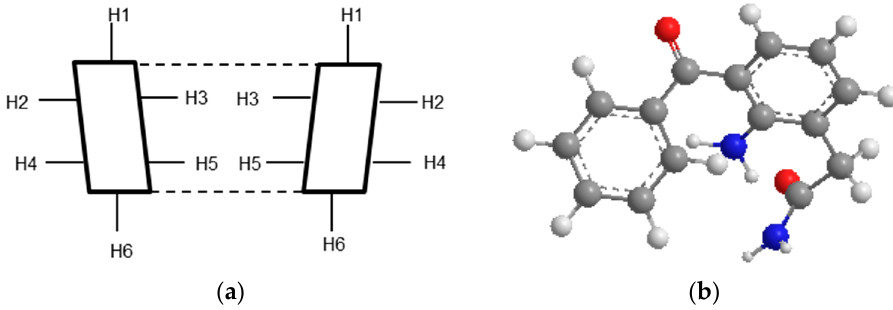
Figure 6. Cross-section of CD molecule ( a ) and nepafenac 3D structure ( b ). Table 4. H-NMR Chemical shift corresponding to free γ CD alone and in the presence of nepafenac. Protons